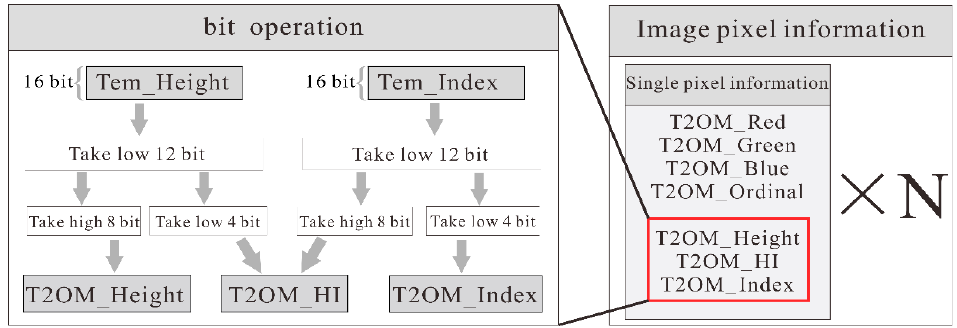
Figure 10. Saving pixel information by bit manipulation.